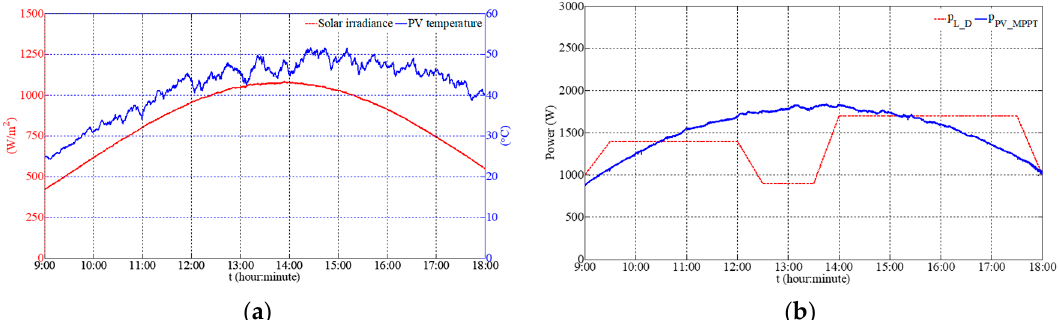
Figure 10. ( a ) Solar irradiance and PV cell temperature and ( b ) Load power demand and PV MPPT power.